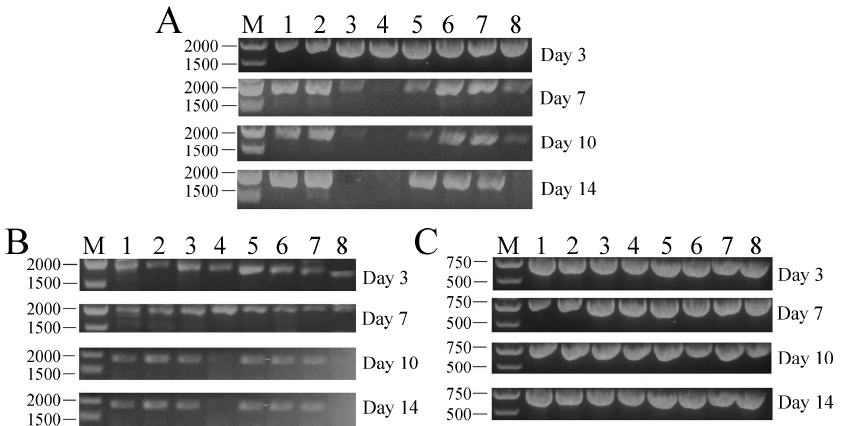
Figure 4. Analysis of the tissue distribution ( A ), and in vivo transcription ( B , C ), in F. chinensis injected with PFc β Int-ER. ( A ) tissue distribution of PFc β Int-ER in shrimp injected with the expression vector at different times by PCR analysis; ( B ) in vivo transcription of PFc β Int-ER in shrimp injected with the expression vector at different times by RT-PCR analysis; ( C ) in vivo transcription of β -actin in shrimp injected with the expression vector at different times by RT-PCR analysis. (Lane M: DNA marker; 1: heart; 2: gill; 3: stomach; 4: hemolymph; 5: intestine; 6: muscle; 7: gonad; 8: hepatopancreas.)